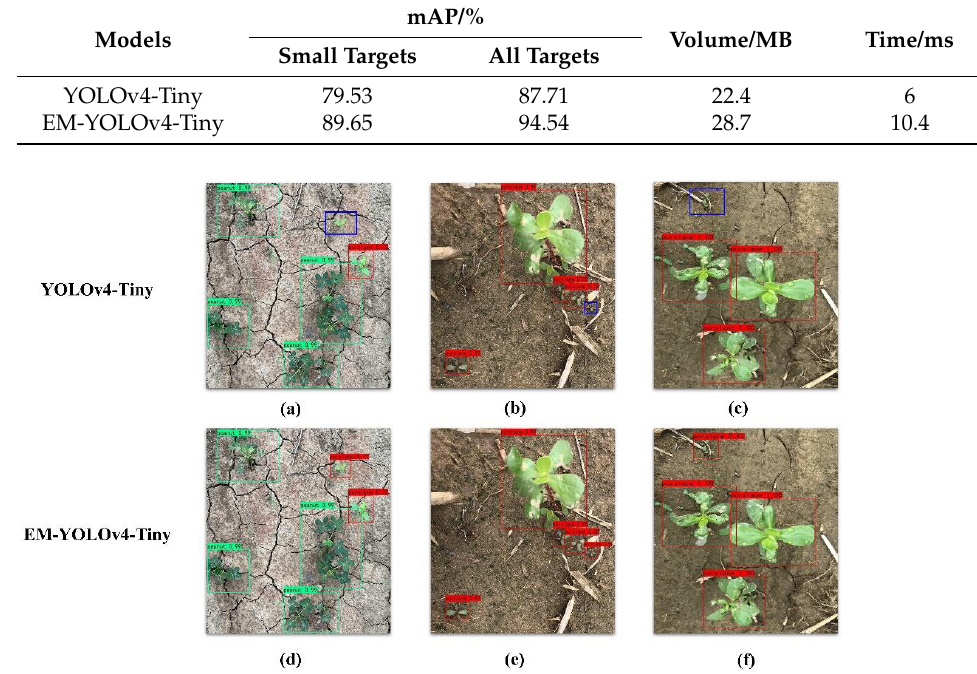
Figure 4. Comparison of detection results of YOLOv4-Tiny and EM-YOLOv4-Tiny, where ( a – c ) represent the recognition effect of the YOLOv4-Tiny model, and ( d – f ) represent the recognition effect of the EM-YOLOv4-Tiny model.